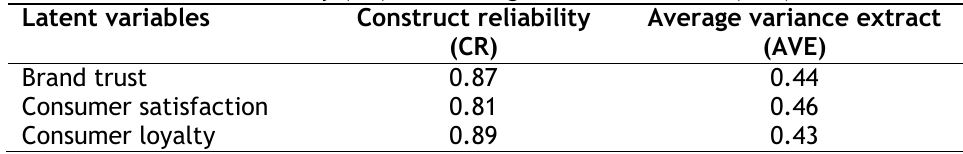
Table 5 . Construct reliability (CR) and average variance extract